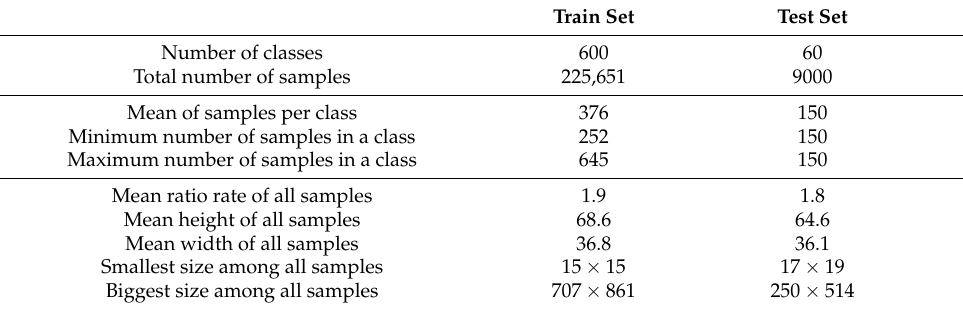
Table 4. Quantitative information about the generated VGGFace-Ear dataset.